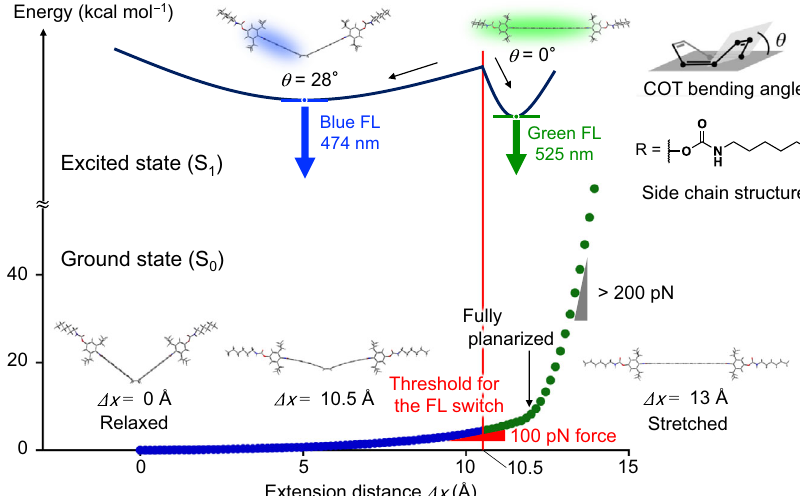
Fig. 3 DFT-calculated energy pro fi le of a polymer-chain substructure in the vicinity of FLAP (R = N -hexylcarbamate in Fig. 2a). Constrained geometry optimization was performed in S 0 at the PBE0/6-31G(d) level (bottom), in which the distance between terminal carbon atoms was fi xed. From the most relaxed geometry, the relative potential energy was scanned as a function of extension, Δ x , by 0.15 Å. Excited-state geometry optimization in S 1 at the TD- PBE0/6-31G(d) level was also performed (top) for each geometry obtained in S 0 , where the extension was fi xed at the same length. The presence of two relaxed conformers of the FLAP skeleton was indicated in S 1 , whose COT bending angles were 28° (bent) and 0° (planar). The conformational coordinates along the abscissa in S 1 (top) are different from those of S 0 (bottom) in this fi